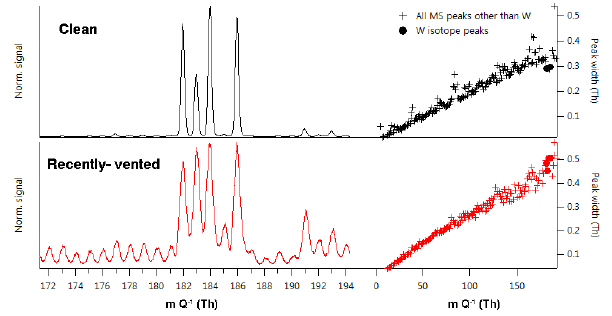
Figure 3. Left: example ToF-ACSM mass spectra for clean and re- cently vented (i.e. dirty) vacuum chambers, showing the tungsten isotope ion pattern superimposed on background peaks of different relative magnitudes. Right: width of the isobaric peaks as a func- tion of mass to charge for the same MS. The solid circles denote the isobars containing the tungsten isotope peaks. These lie under the general trend in the clean case but follow the trend in the recently vented case. Owing to instrument tuning, the peaks are generally broader in the recently vented